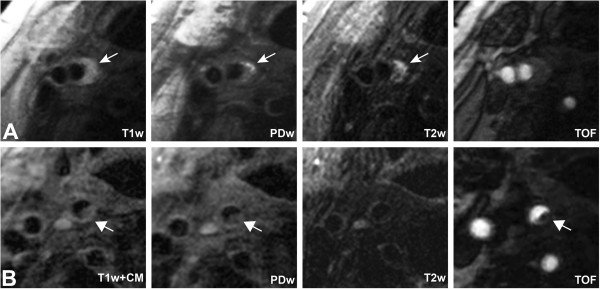
Axial images of specific AHA-LT VI plaque features in a patient with acute ischemic infarct. High-resolution black blood MRI of the carotid arteries demonstrate a large eccentric plaque with <50% stenosis in the right carotid artery, hyperintense on T1w, T2w and PDw sequences consistent with fresh intraplaque hemorrhage (A, arrow). Axial images 0.6 cm above the bifurcation show an area attached to the plaque, which is hypo- to isointense on T1w + CM, PDw and TOF, consistent with a mural thrombus (B, arrow). (T1w: T1-weighted black blood sequence, PDw: PD-weighted sequences, T2w: T2-weighted sequence, TOF: Time-of-flight MR angiography, T1w + CM: T1-weighted black blood sequence after contrast administration).